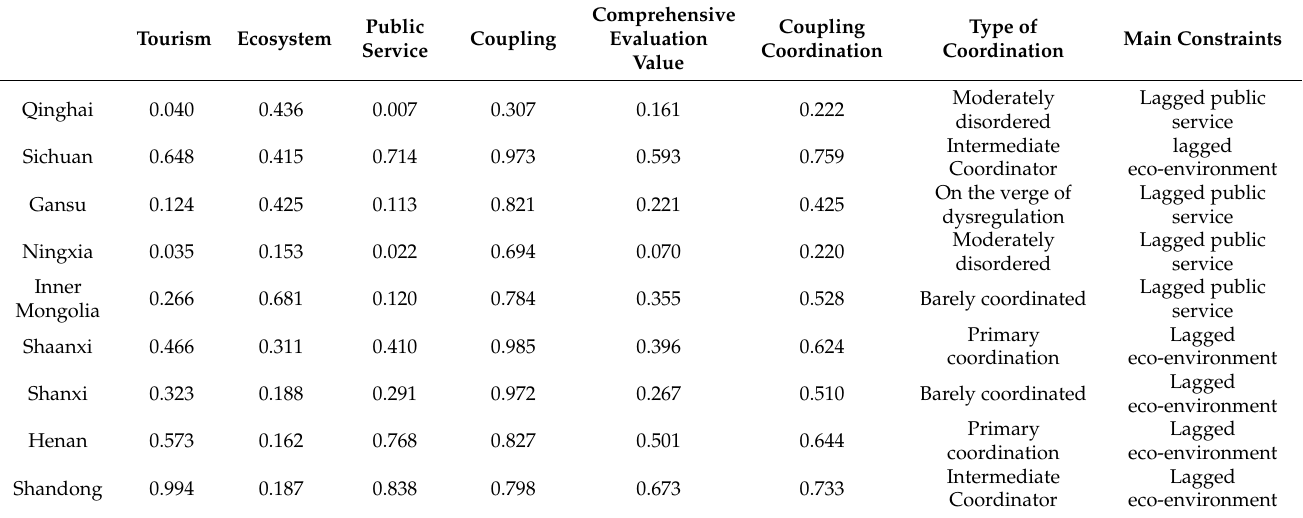
Table 5. Comparison of Mean Values of Tourism, Ecological Environment and Public Service Coupling Coordination Among provinces in the Yellow River Basin from 2008 to 2019.